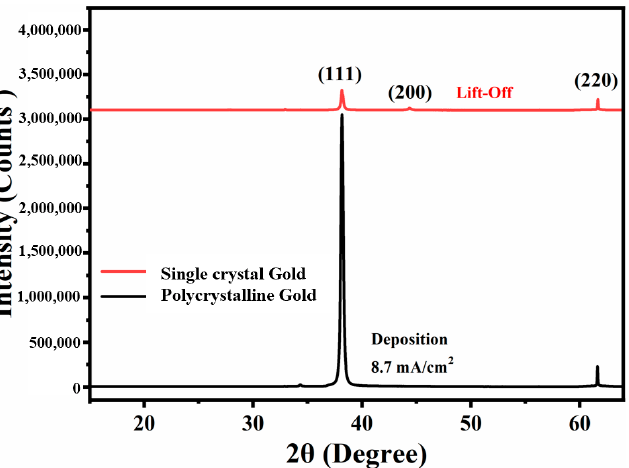
Figure 2. The X-ray diffraction (XRD) spectrum of gold film for lift-off process and deposition processes.